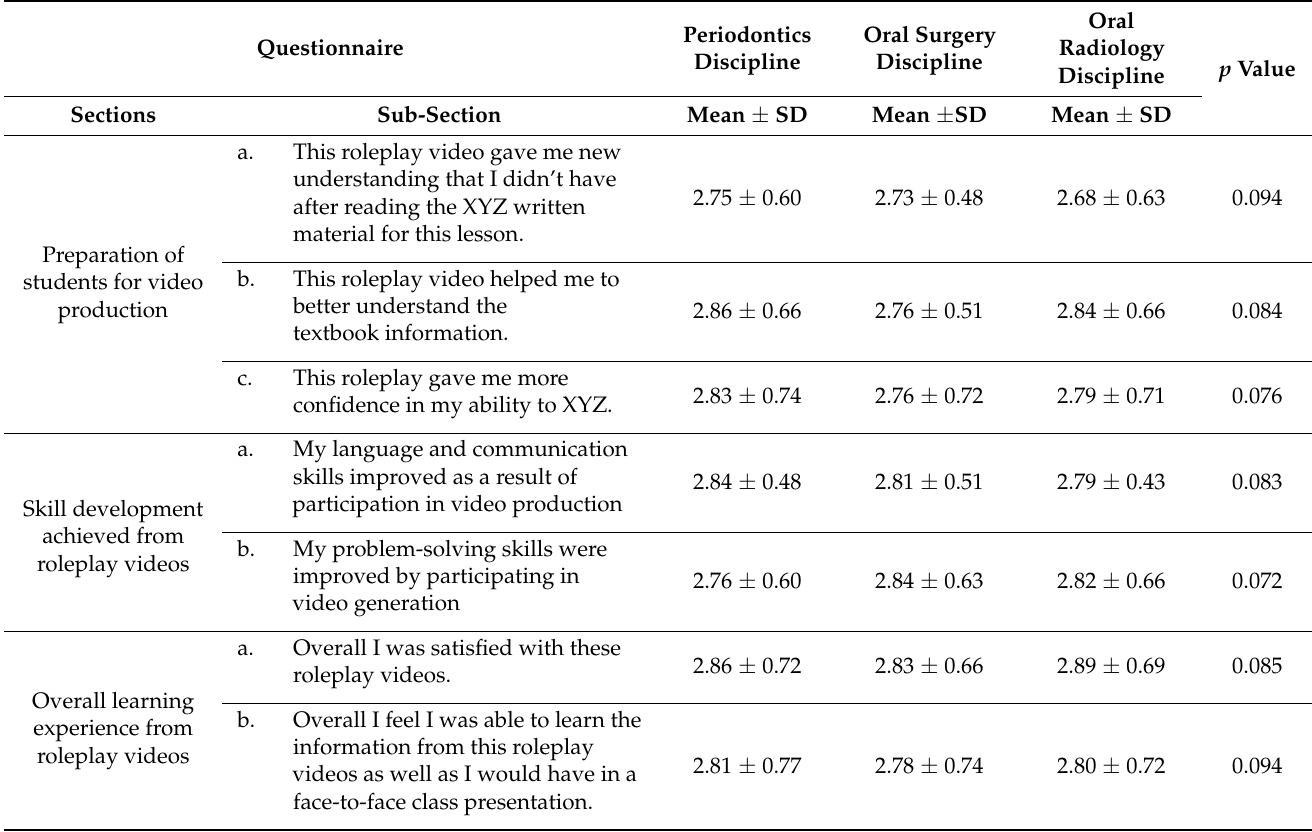
Table 1. Comparison of feedback responses for roleplay videos implemented in various disciplines of the BDS course.